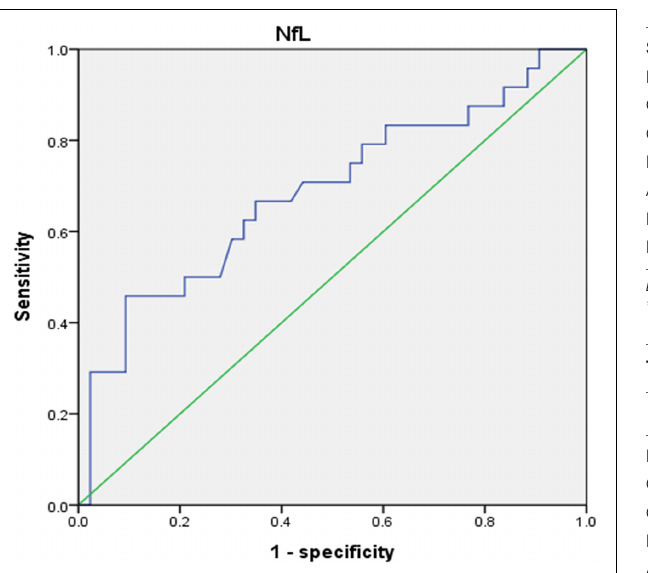
FIGURE 2 | The ROC curve of the NfL for cognitive impairment of in ESRD.